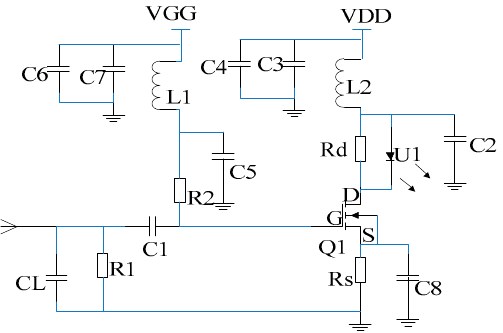
Figure 2. The electro-optic modulation circuit. The entire shell is divided into left and right parts by an insulating medium: The left shell is equivalent to a grounding mechanism, and the right shell plays a different role according to the strength of the EMP field. For the weak field sensor, the right shell is electrically connected with the antenna port of the electro-optic modulation circuit by a wire; in this case, the length of the right shell is similar to length of the left shell, and this kind of shell structure acts as a dipole antenna for detecting small signals. However, when the detected signal is so large that it exceeds the linear range of the FET Q1 and enters into the saturation region of FET Q1, it can cause a distortion of the detected signal. Obviously, the above dipole antenna is not suitable for detecting a strong EMP field. Therefore, the strong field sensor was designed by changing the type of the antenna, and we took a short wire welded at the antenna port of the electro-optic modulation circuit as the